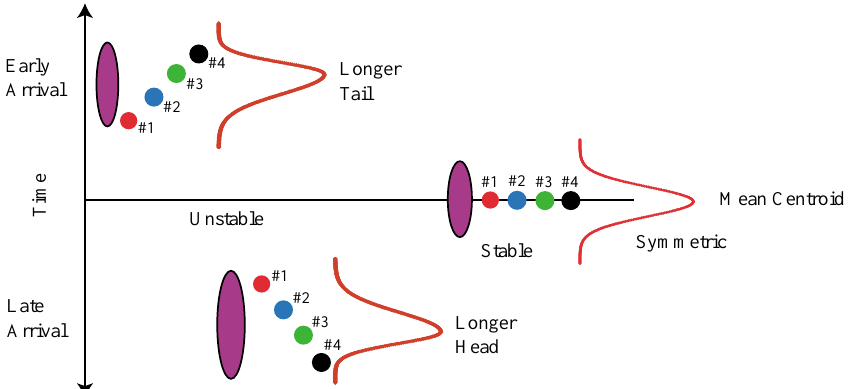
FIG. 30. (Color) The longitudinal dynamics with multiple trains present in CESR.